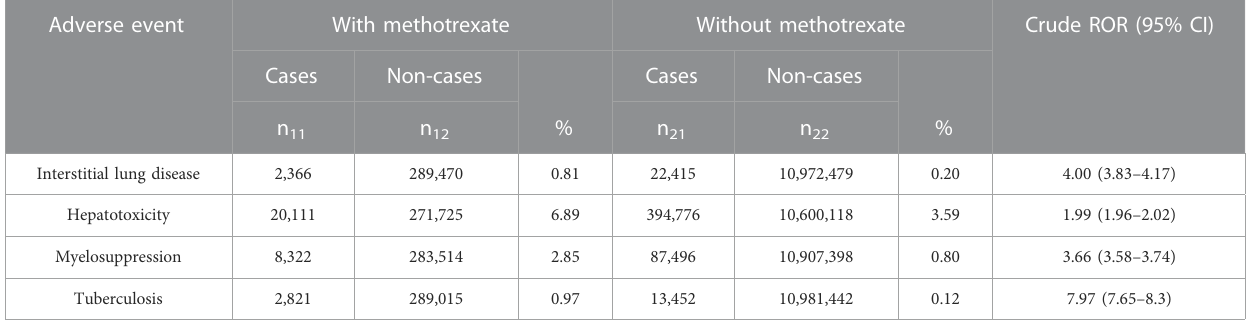
TABLE 1 Crude RORs (95% CI) for MTX-related adverse events in cases of MTX use.